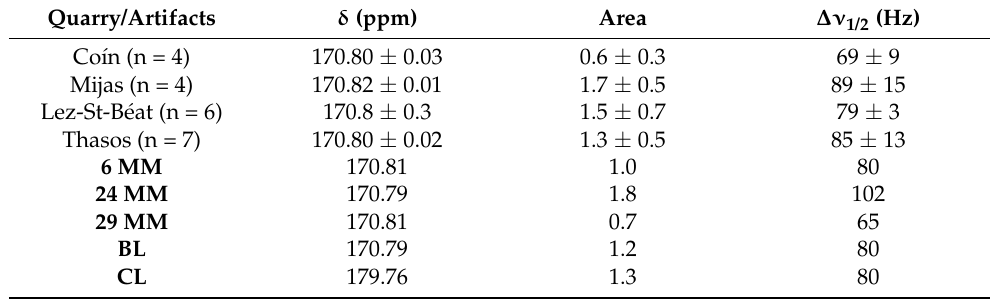
Table 1. Physico-chemical parameters extracted from 13 C NMR spectra of quarries and artefacts. δ corresponds to the NMR 13 C chemical shift with respect to tetramethyl silane, which resonates at 0 ppm; area is the integration of the area of the signal with respect to an external reference; ∆ ν 1/2 is the full width at half-maximum of the carbonate resonance. All of the values are expressed as average ± STD. Details are reported on Table S3.